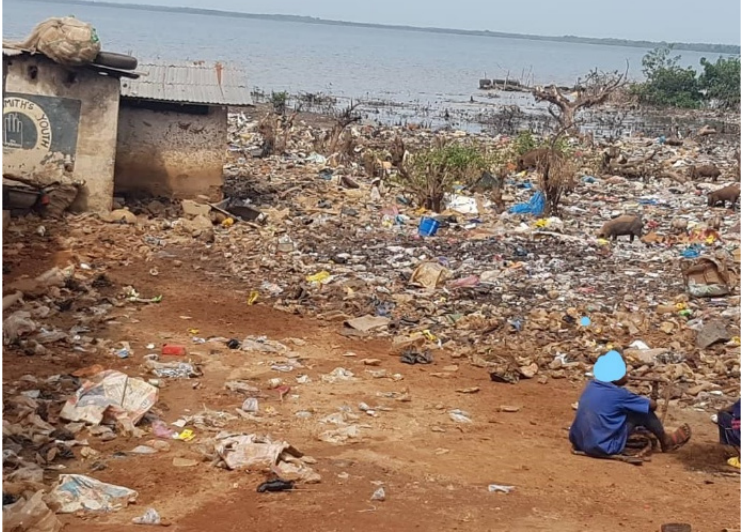
Figure 5. Cleared mangrove plantation that once protected land and other nearby structures from coastal flooding. Source: Fieldwork